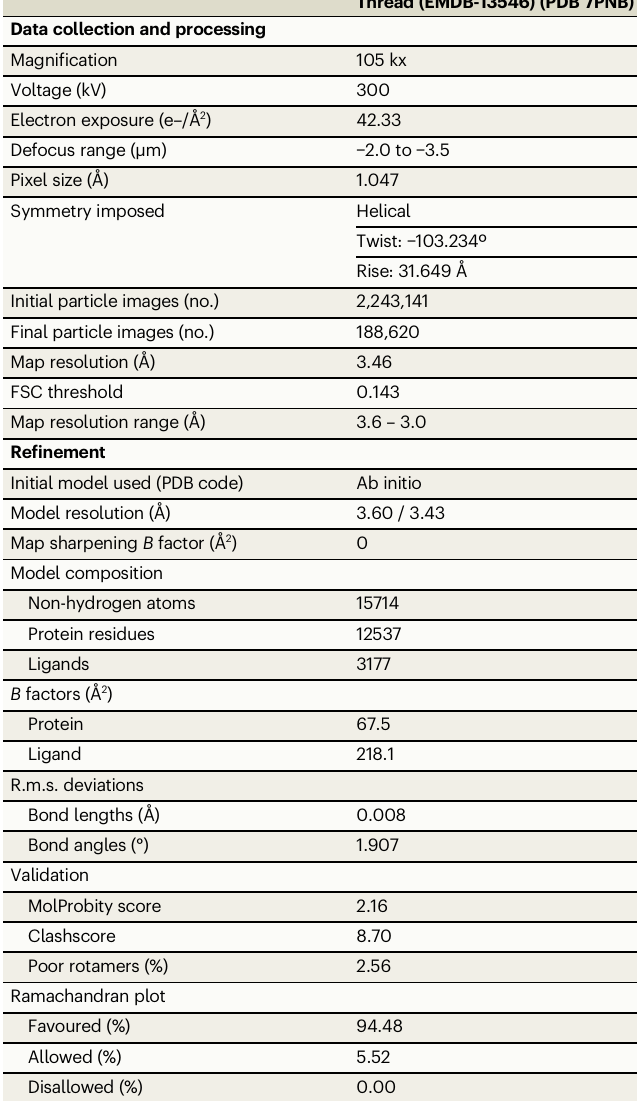
Table 1 | CryoEM data collection, re fi nement and